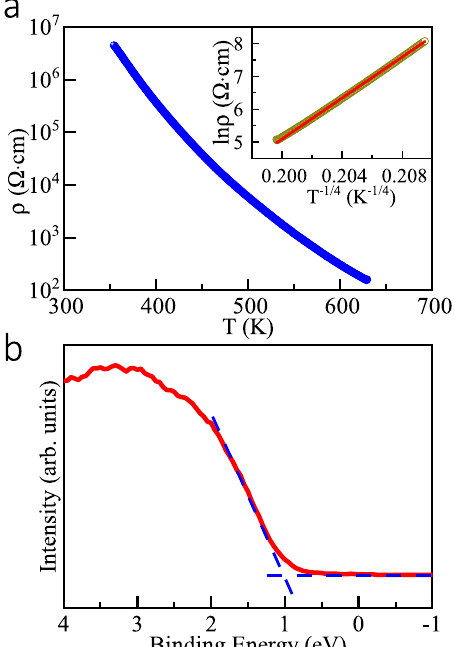
Fig. 3 Electrical properties of PbFeO 3 . a Temperature dependence of resistivity measured above RT for PbFeO 3 . Inset shows 3D VRH model fi tting between 520 and 630 K. b HAXPES spectrum near valence band for PbFeO 3 . The energy bandgap is evaluated to be ~1 eV.